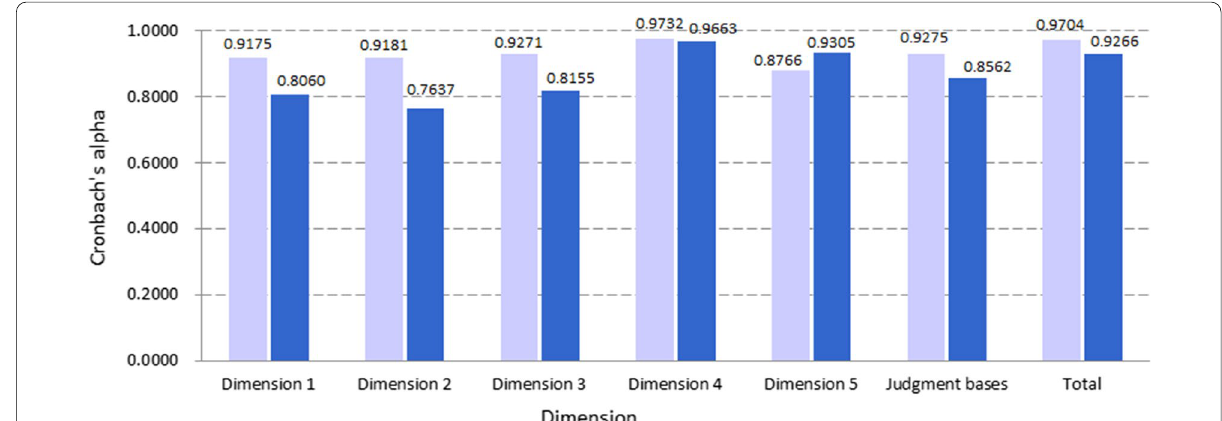
Fig. 5 Cronbach’s alphas among